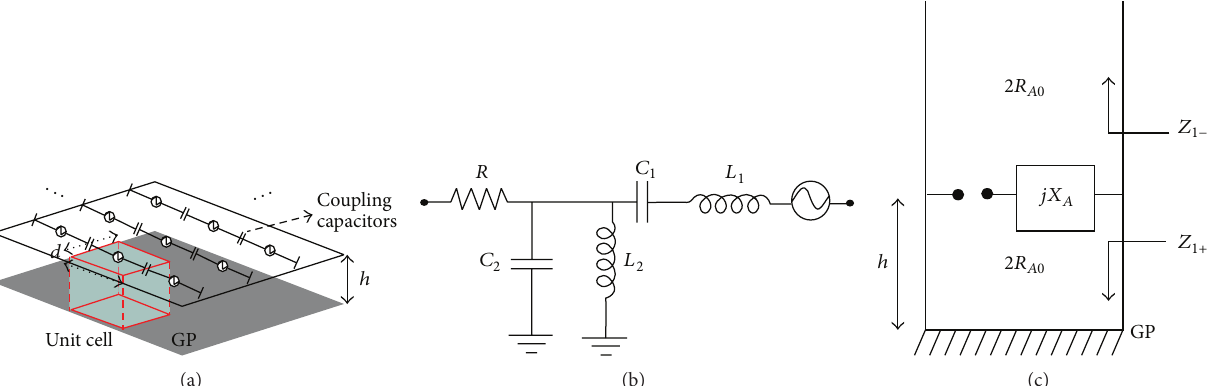
Figure 3: (a) General representation of the metamaterial (MTM) array with definition of unit cell, (b) equivalent circuit of MTM array unit cell, and (c) transmission line circuit representation of the array on a ground plane from [46].